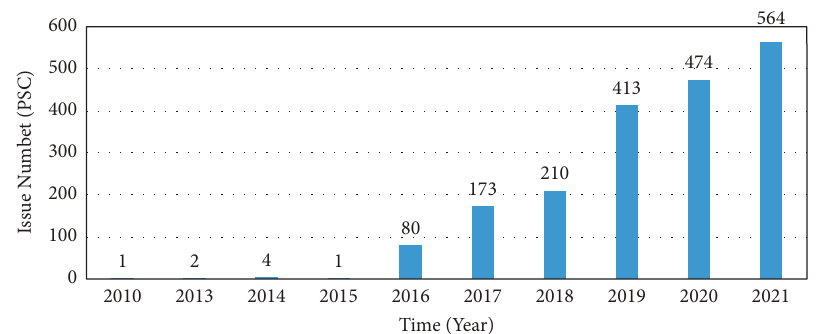
Figure 1: Annual Green Bond Issuance Data in China (Data source: wind, compiled by the